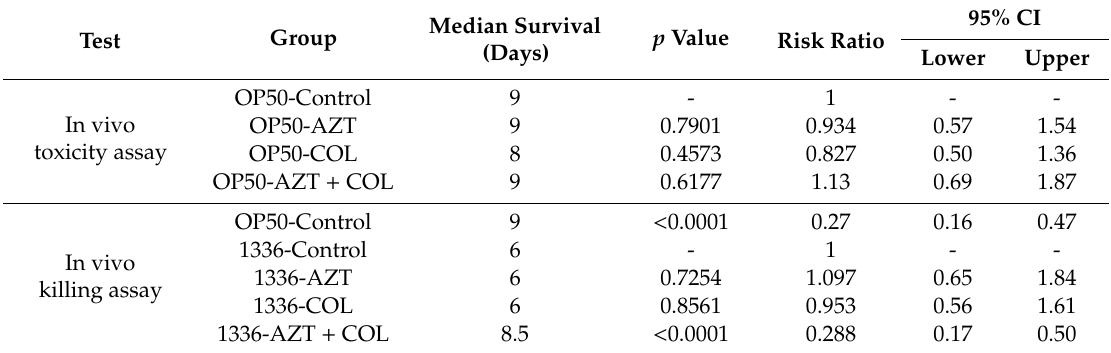
Table 5. Statistical analyses of in vivo C. elegans toxicity testing and killing assays.